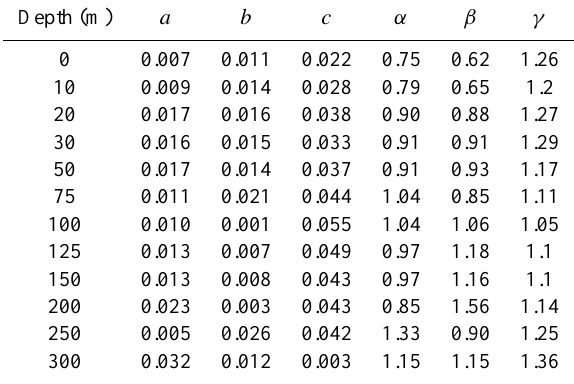
Table 2. Parameters of the mean correlation model, ρ(1x , 1y